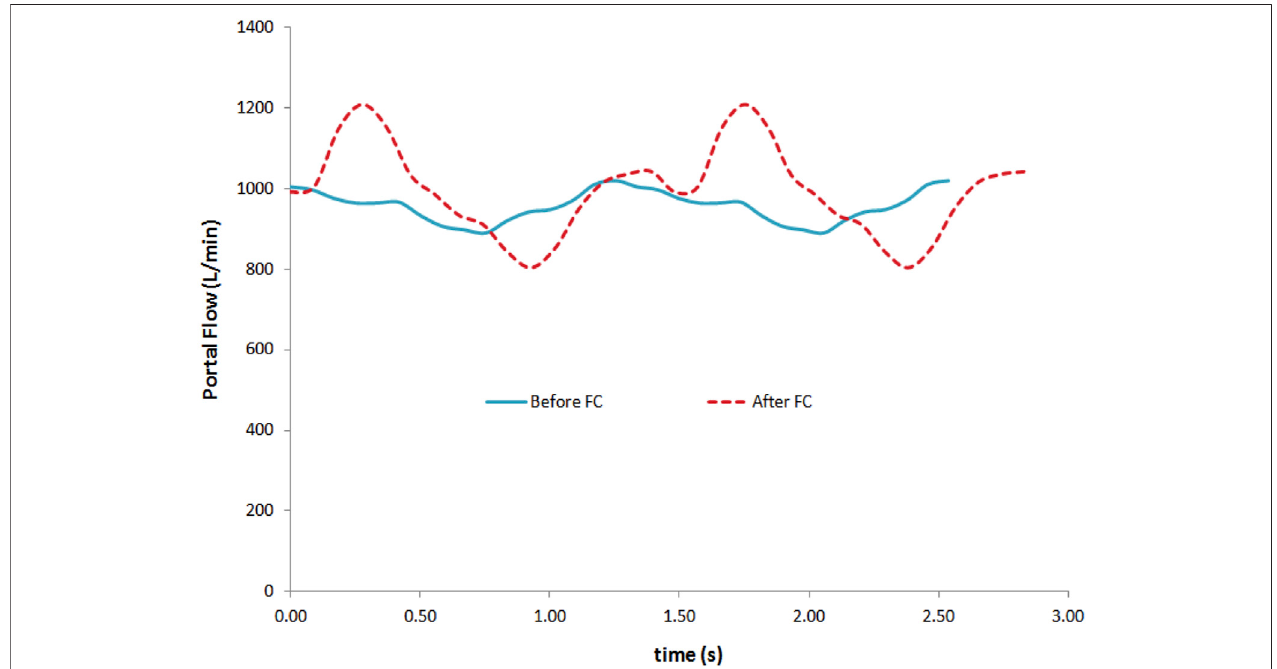
FIGURE 1 | Portal fl ow rate from a subject before (continuous) and after (dotted line) the fl uid challenge (FC) during two cardiac cycles in a non-responder subject. The curve signal evolved from low to high pulsatility.